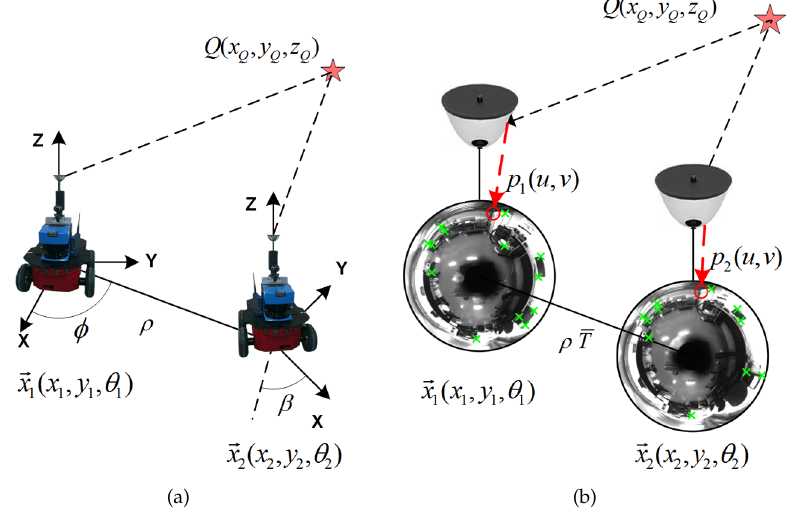
Figure 3. Omnidirectional visual localization between poses (cid:126) x 1 and (cid:126) x 2 . ( a ) a 3D point Q ( x Q , y Q , z Q ) is observed from the robot reference system; ( b ) additionally, the projections of Q , p 1 ( u , v ) , and p 2 ( u , v ) are presented onto the camera reference